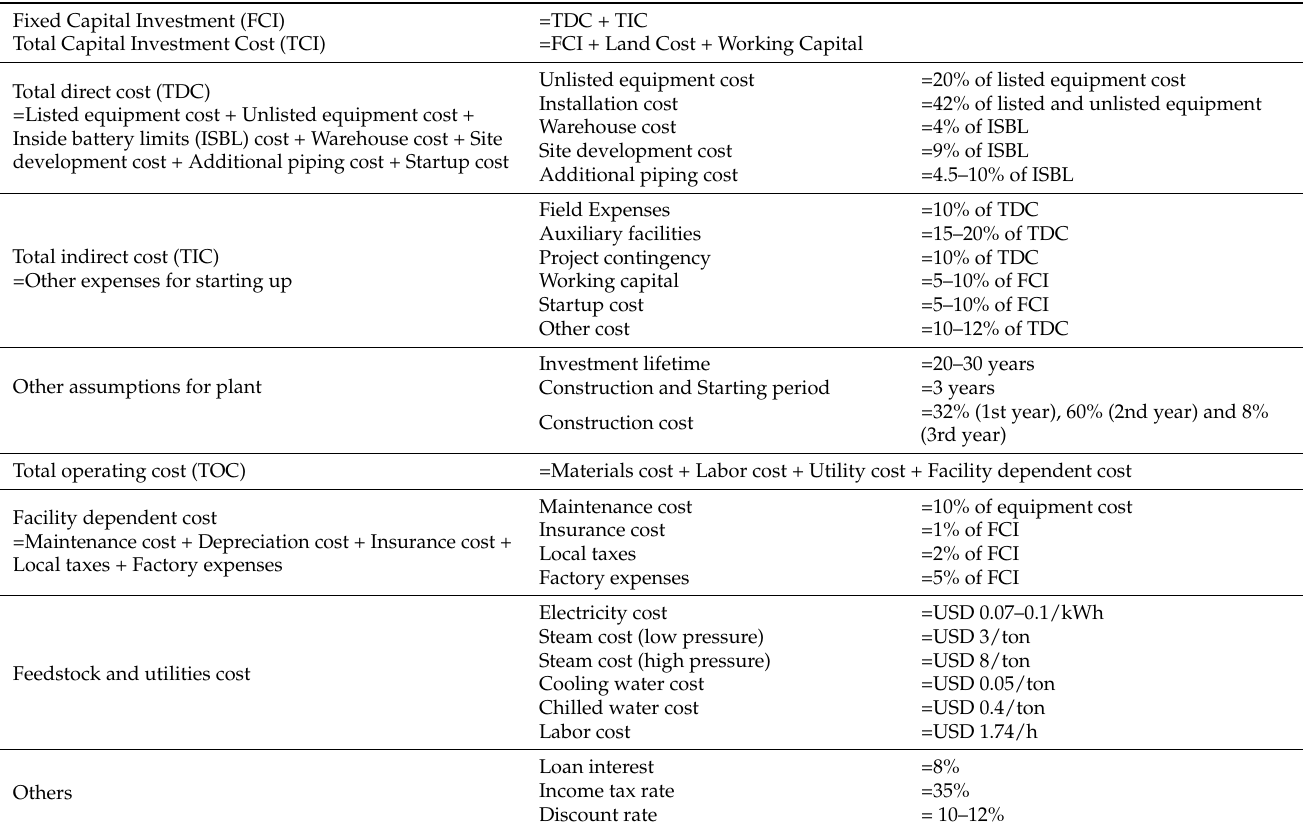
Table 3. Assumptions used in techno-economic assessment of co-production of 2G bioethanol and biogas (data summarized from [61,76,92,95–97]). Fixed Capital Investment